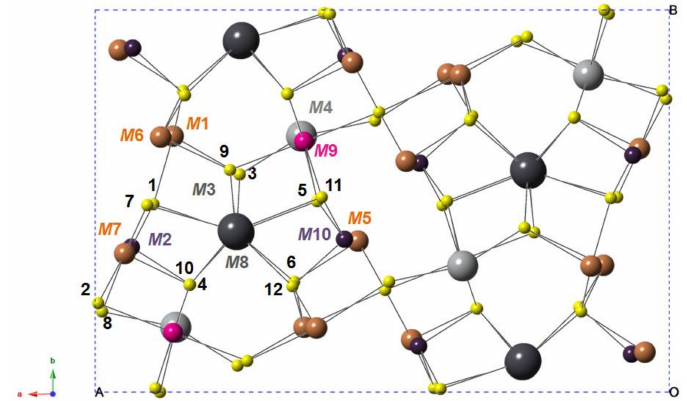
Figure 2. Unit-cell content of oyonite as seen down c . Circles: dark grey = Pb sites; light grey = Ag sites; orange = Sb sites; violet = As site; purple = Mn site; yellow = S sites. Atom labels as in Table 3 (for S sites, only the number is